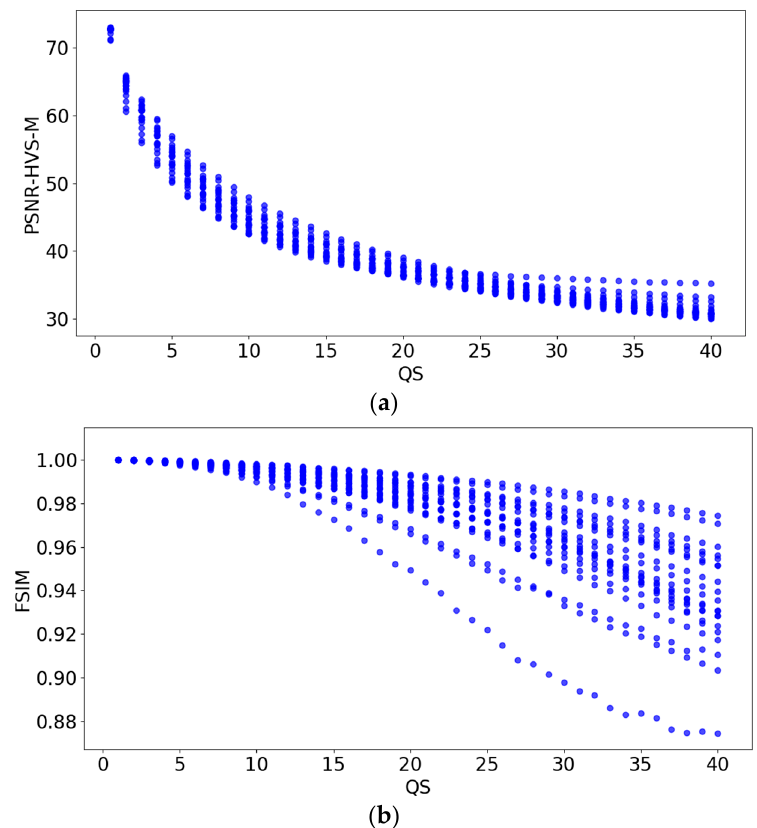
Figure 6. Dependences of PSNR-HVS-M ( a ) and FSIM ( b ) on QS for image fragments.